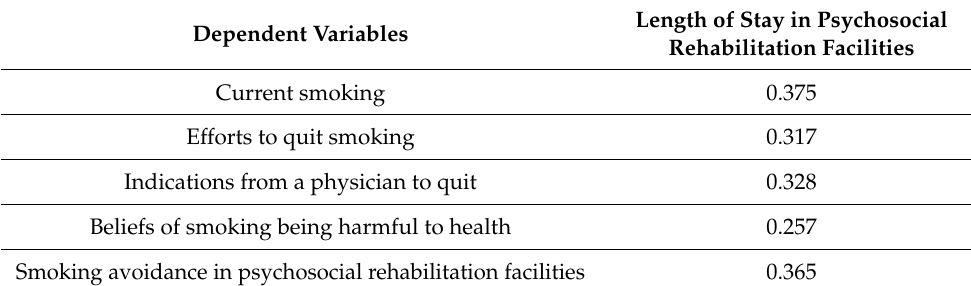
Table 5. Correlation of smoking habits with patients’ length of stay in the